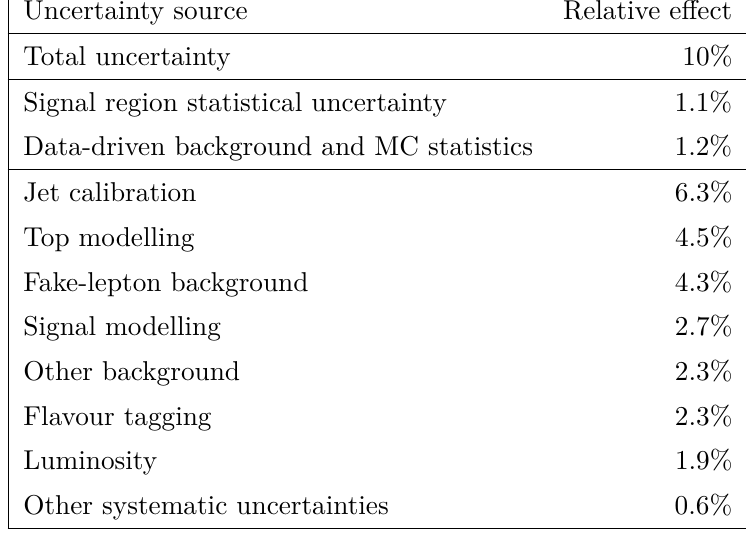
Table 6 . Breakdown of the uncertainties in the measured fiducial cross-section. “Jet calibration” uncertainties encompass jet energy scale and resolution uncertainties, “Top modelling” and “Signal modelling” are uncertainties in the theoretical modelling of the respective processes, “Fake-lepton background” is the uncertainty in the fake-lepton estimate while “Other background” is the uncer- tainty due to minor prompt-lepton backgrounds, “Flavour tagging” is all uncertainties in flavour tagging efficiency and mis-tag rate, and “Luminosity” is the uncertainty in the measurement of the integrated luminosity. All systematic uncertainties belonging to none of the above categories are included in “Other systematic uncertainties”. Statistical uncertainties arise in both the signal region and control region used for the data-driven top and fake-lepton estimates and also from backgrounds that are estimated using MC